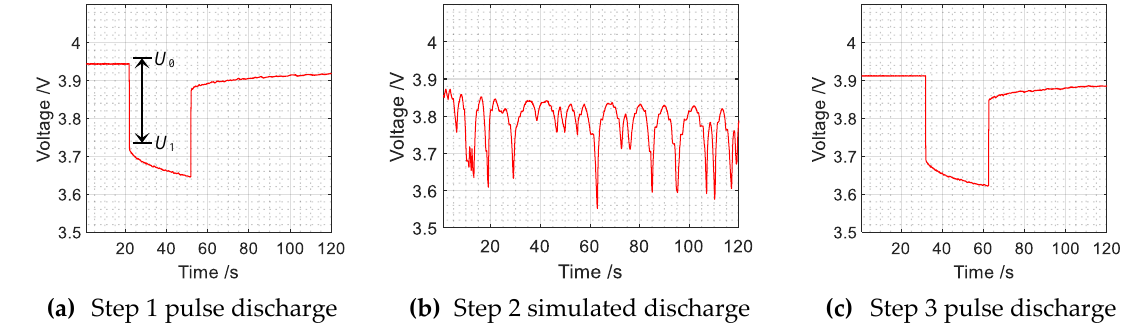
Figure 6. The terminal voltage curve of the cell being tested.